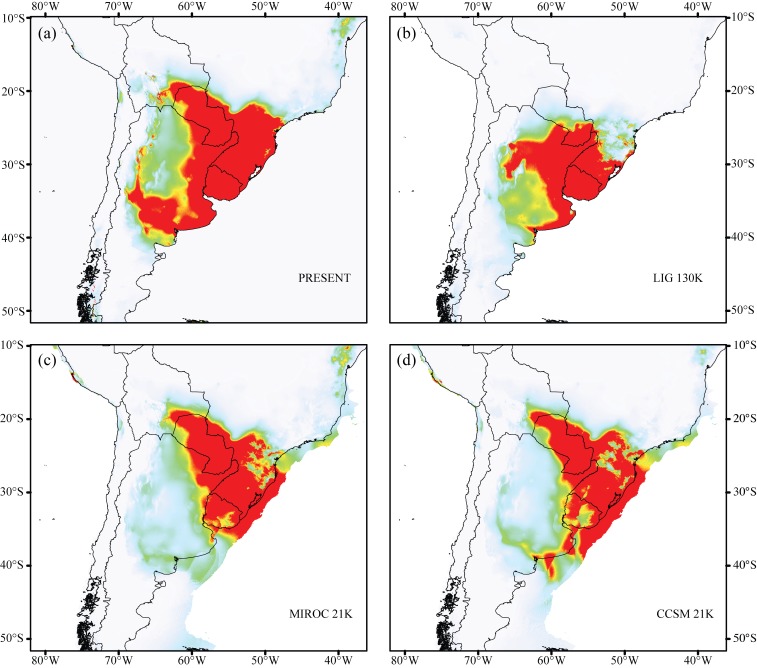
Geographical distribution for climatically predicted areas for the occurrence of Acromyrmex striatus based on current and past bioclimatic variables.(a) potential distribution under current conditions, (b) LIG 130K: last interglacial period (130,000 years before present), (c) MIROC 21k and (d) CCSM 21k: last glacial maximum (21,000 years before present). Warm colors (red/yellow) represent areas with high probability of A. striatus.